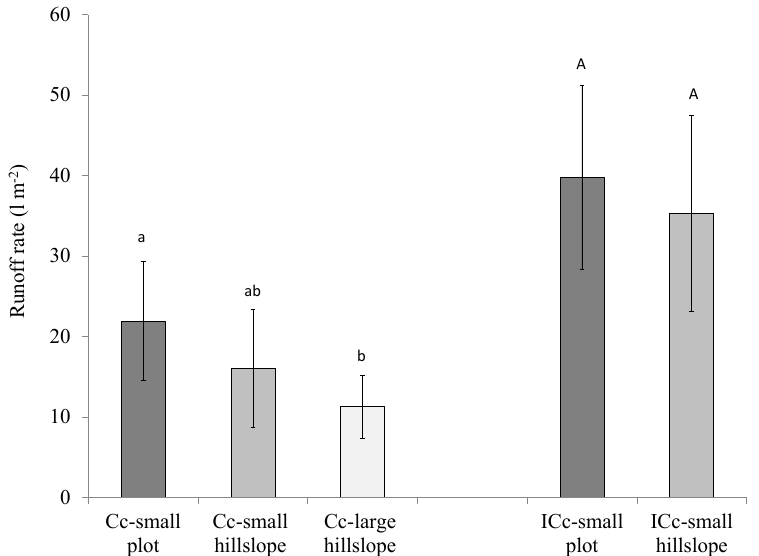
Figure 5. Total runoff rates during the period shown in Table 2 (26 January–21 March 2010) in well-developed cyanobacterial (C C ) and incipient-cyanobacterial (IC C ) biocrusts at El Cautivo, at plot (~1 m 2 ), small-hillslope (~10 m 2 ) and large-hillslope (~20 m 2 ) scales. There were no plots at large-hillslope scale for the IC C crust. Different letters indicate significant differences ( p < 0.05) among spatial scales for each crust type.